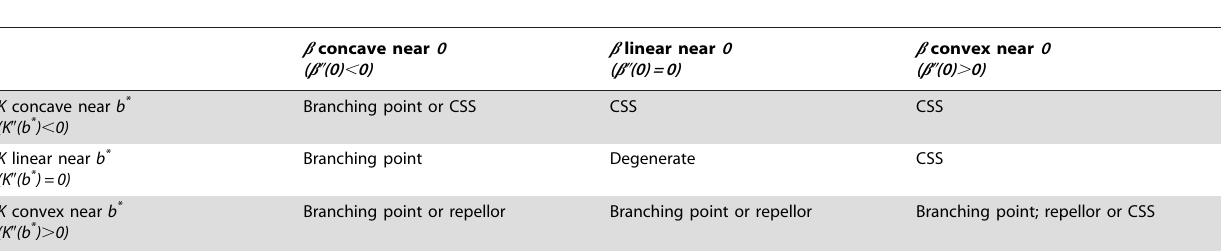
Table 1. Possible evolutionary singularities ( b * ) with different functional forms of K and b .